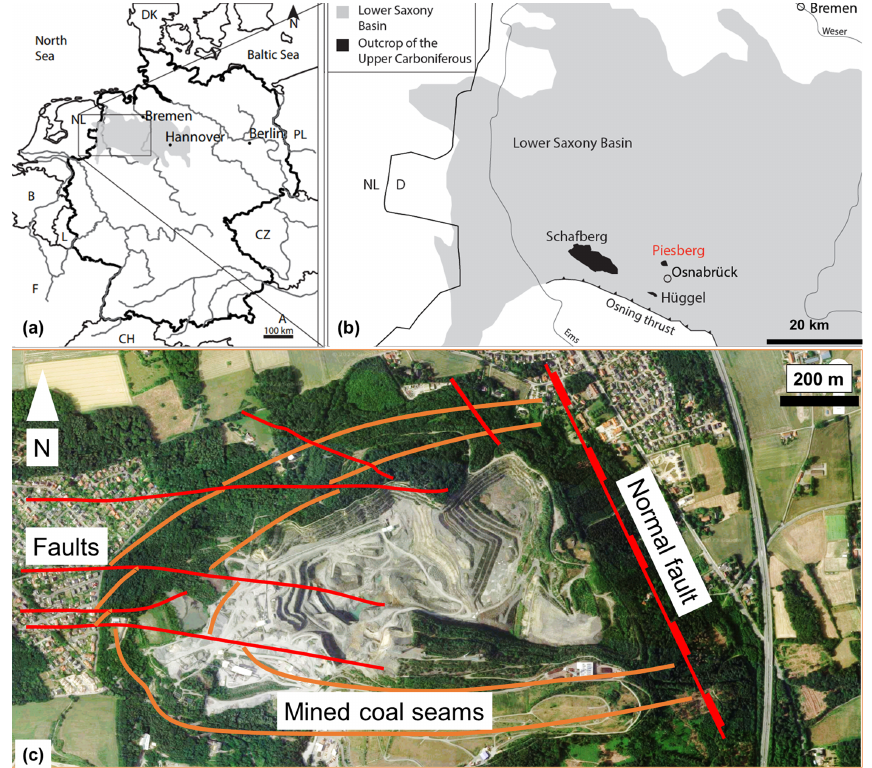
Figure 1. (a) Location of the studied area in northwestern Germany. (b) Detailed location of the investigated Piesberg quarry at the southern rim of the LSB (redrawn from Senglaub et al., 2006 and Busch et al., 2019). (c) Aerial image of the Piesberg quarry (© Google Maps, 2023). The coal seams, faults, and the main normal fault in the east are based on historical subsurface mining data (Haarmann, 1909; Wüstefeld et al., 2017b).